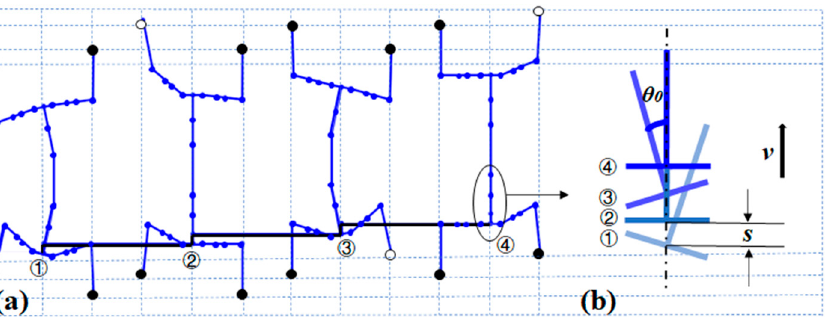
gle about central line.